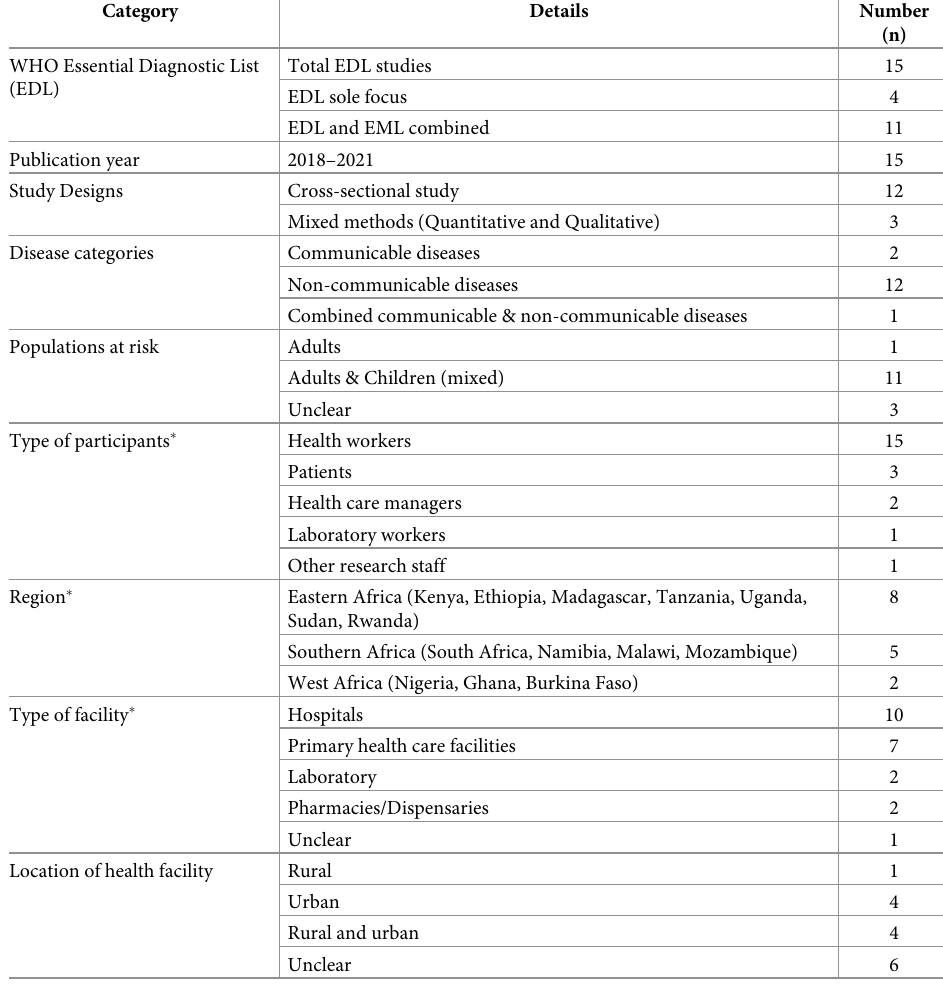
Table 1. Characteristics of studies about the Essential In Vitro Diagnostics List